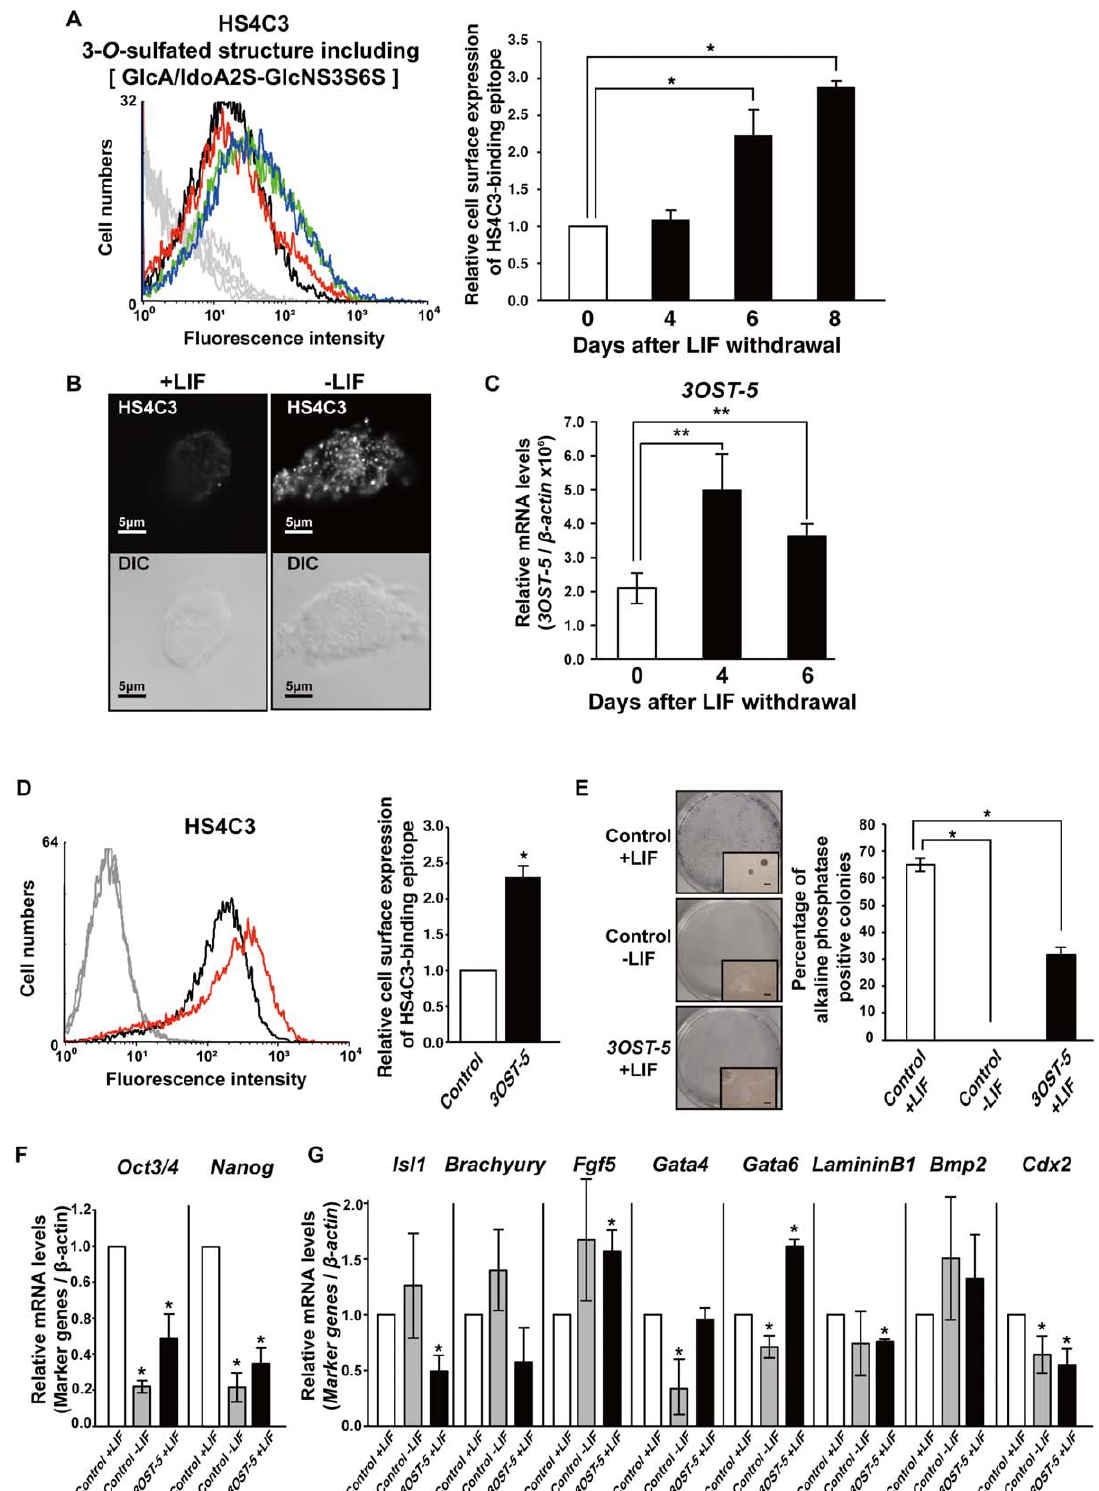
Figure 1. Increase in the HS4C3-binding epitope induces differentiation. (A) FACS analysis, using the HS4C3 antibody, of mESCs after LIF withdrawal up to day 8. mESCs were cultured in the presence of LIF until day 0. In the left panel , a histogram shows a representative result of the FACS analysis ( black line , in the presence of LIF; red line , 4 days after LIF withdrawal; green line , 6 days after LIF withdrawal; blue line , 8 days after LIF withdrawal). The gray line shows the result obtained from cells not treated with primary antibody. In the right panel , the values shown are the mean fluorescence intensity 6 SD after normalization against mESCs cultured in the presence of LIF (arbitrary value=1). (B) Immunostaining, using the HS4C3 antibody, of non-permeabilized mESCs cultured in the presence of LIF ( + LIF) or mESCs cultured for 7 days in the absence of LIF ( 2 LIF) ( upper panel ). Lower panel shows DIC images. Scale bar, 5 m m. Representative confocal images are shown. (C) Real time PCR analysis of mESCs after LIF